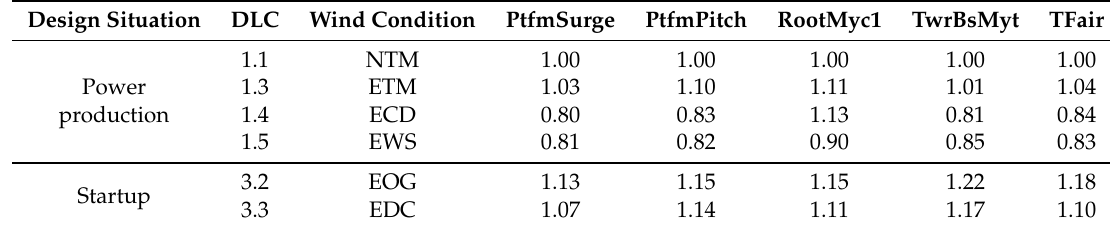
Table 13. Turbine system response for selected design load cases. DLC, design load case; NTM, normal turbulence model; ETM, extreme turbulence model; ECD, extreme coherent gust with direction change; EWS, extreme wind shear; EOG, extreme operating gust; EDC, extreme direction change. Design Situation